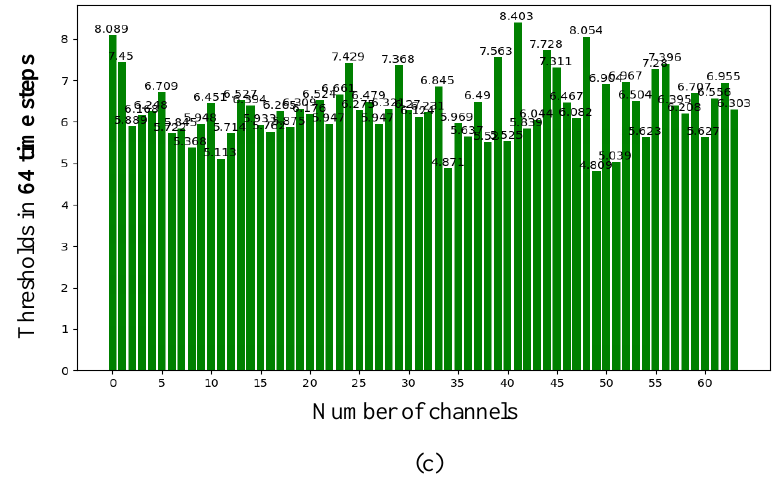
Figure A4. Assigned thresholds of the soft-reset IF neurons in the SNN on the MNIST dataset. ( a ) assigned threshold of the soft-reset IF neurons in the first layer; ( b ) assigned threshold of the soft-reset IF neurons in the second layer with the latency of 4 time steps; ( c ) assigned threshold of the soft-reset IF neurons in the second layer with the latency of 64 time steps.